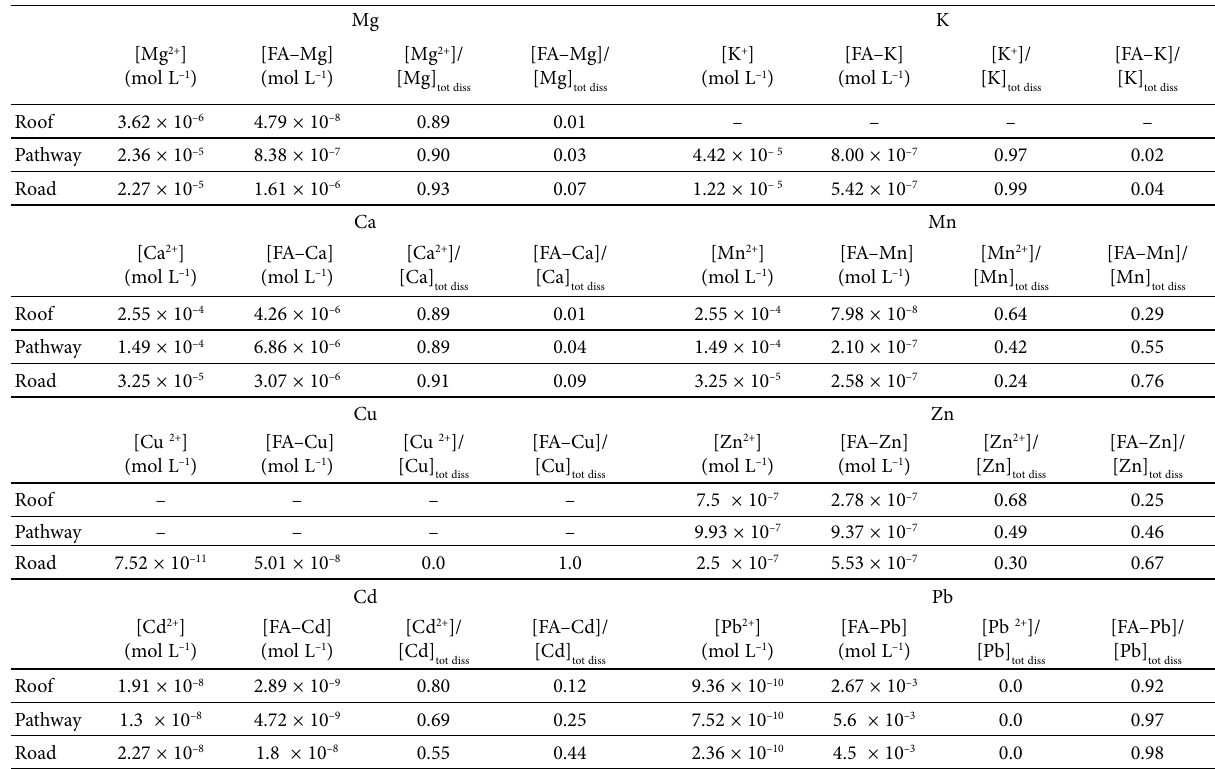
Fig. 3. Average concentration of the trace metals detected in soluble (a) and insoluble (b) forms in urban storm water runoff samples from the investigated Table 6. Free ion activity and fraction bound to colloid (FA) of trace metals and macro elements in urban storm water runoff (USWR) from different surfaces, calculated by WHAM. [FA – M], concentration of M, trace metals and macro elements, bound to fulvic acids, FA. [ ] tot. diss., total dissolved concentration of trace metals and macro